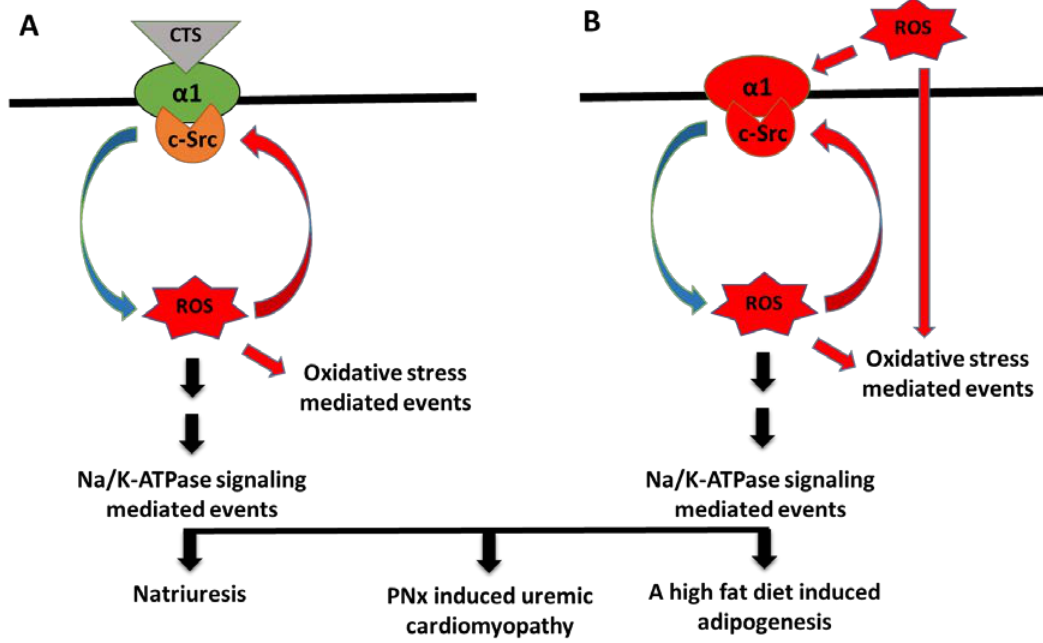
Figure 1. Illustration of the Na/K-ATPase signaling-mediated oxidant amplification loop, showing increases in cardiotonic steroids (CTS) ( A ) or increases in ROS within physiological range ( B ); stimulated oxidant amplification loop. Increases in CTS alone or increases in ROS alone or a combination of increases in CTS and ROS (not shown) stimulate Na/K-ATPase/c-Src signaling to induce Na/K-ATPase signaling-mediated events, such as renal sodium handling in proximal tubules (natriuresis), PNx-induced uremic cardiomyopathy and a high fat diet-induced adipogenesis. Acknowledgments: This work was supported by NIH R15 1R15DK106666-01A1 (to Jiang Liu) and NIH RO1 HL071556 (to Joseph I. Shapiro).